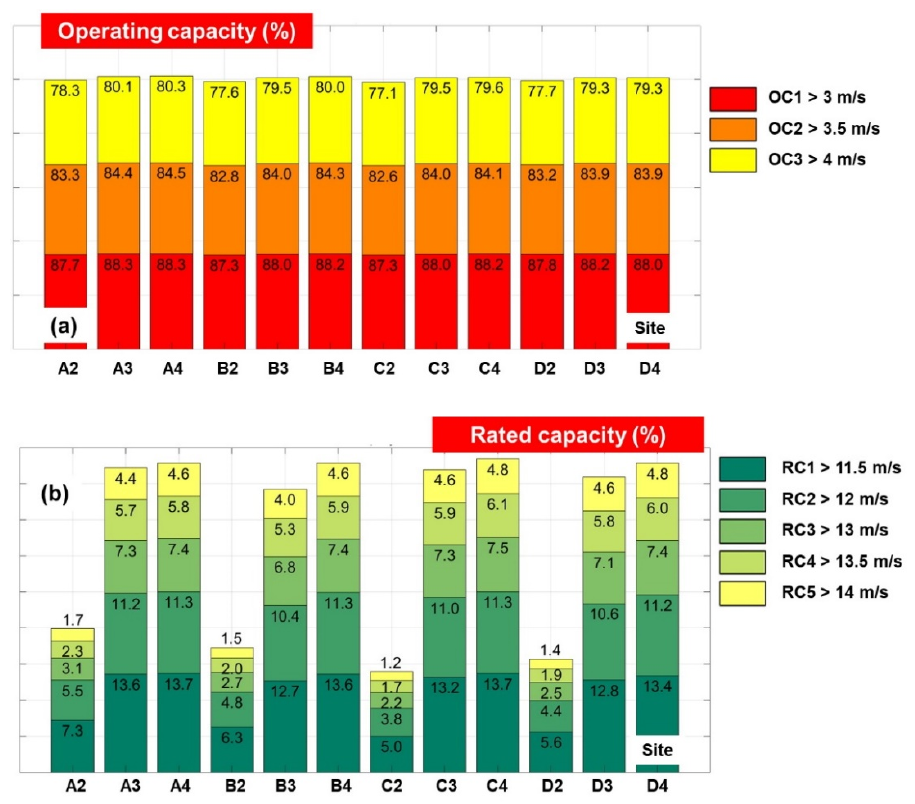
Figure 8. Performances of the selected wind turbines, for the time interval from January 2000 to December 2019. Results indicated for: ( a ) Operating capacity; ( b ) rated capacity. The OC and RC selection are based on the most frequent cut-in and rated speed values indicated by the current offshore wind turbines (see Table 2).